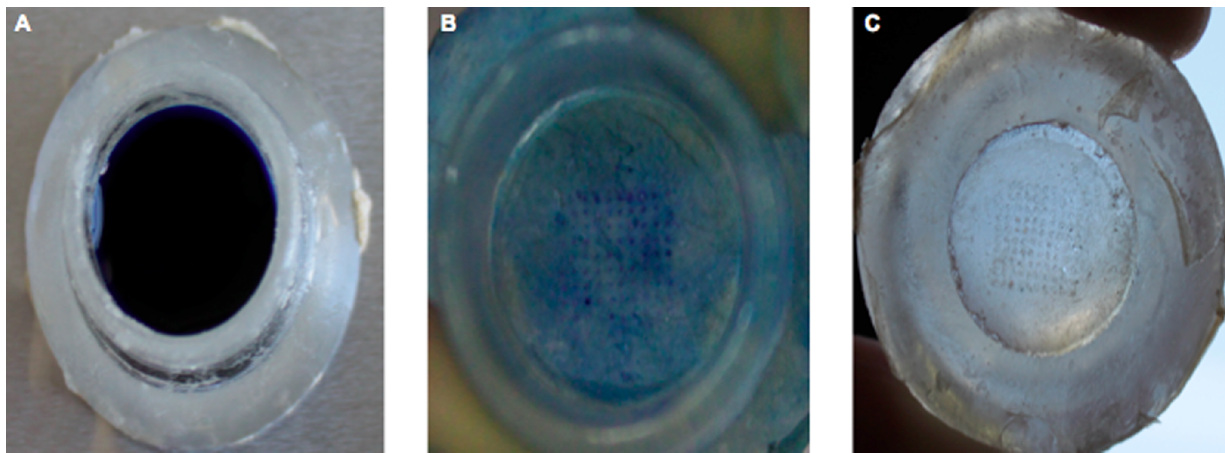
Figure 5. Skin micro-drilled with MNs. ( A ) A representative image of the methylene blue-filled donor compartment phase of the Franz diffusion cell, beneath which the dermatomed human skin was placed. ( B ) A representative image of the stratum corneum side of the dermatomed human skin at the end of the 24-h diffusion studies. The 10-by-10 (100) microholes that were created in the skin are shown. ( C ) A representative image of the underside of the dermatomed human skin at the end of the 24-h diffusion studies.